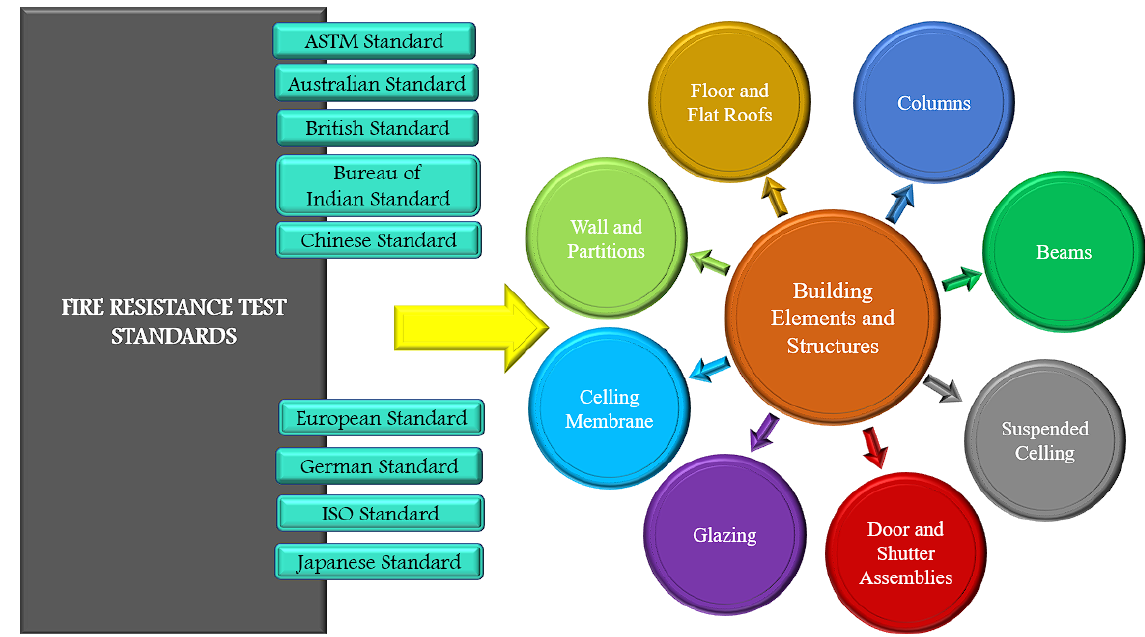
Figure 1. Fire ‐ resistance ‐ test standards for building elements and structures. Figure 1. Fire-resistance-test standards for building elements and structures. Table 2. Fire-resistance standards for general principles and requirements of construction